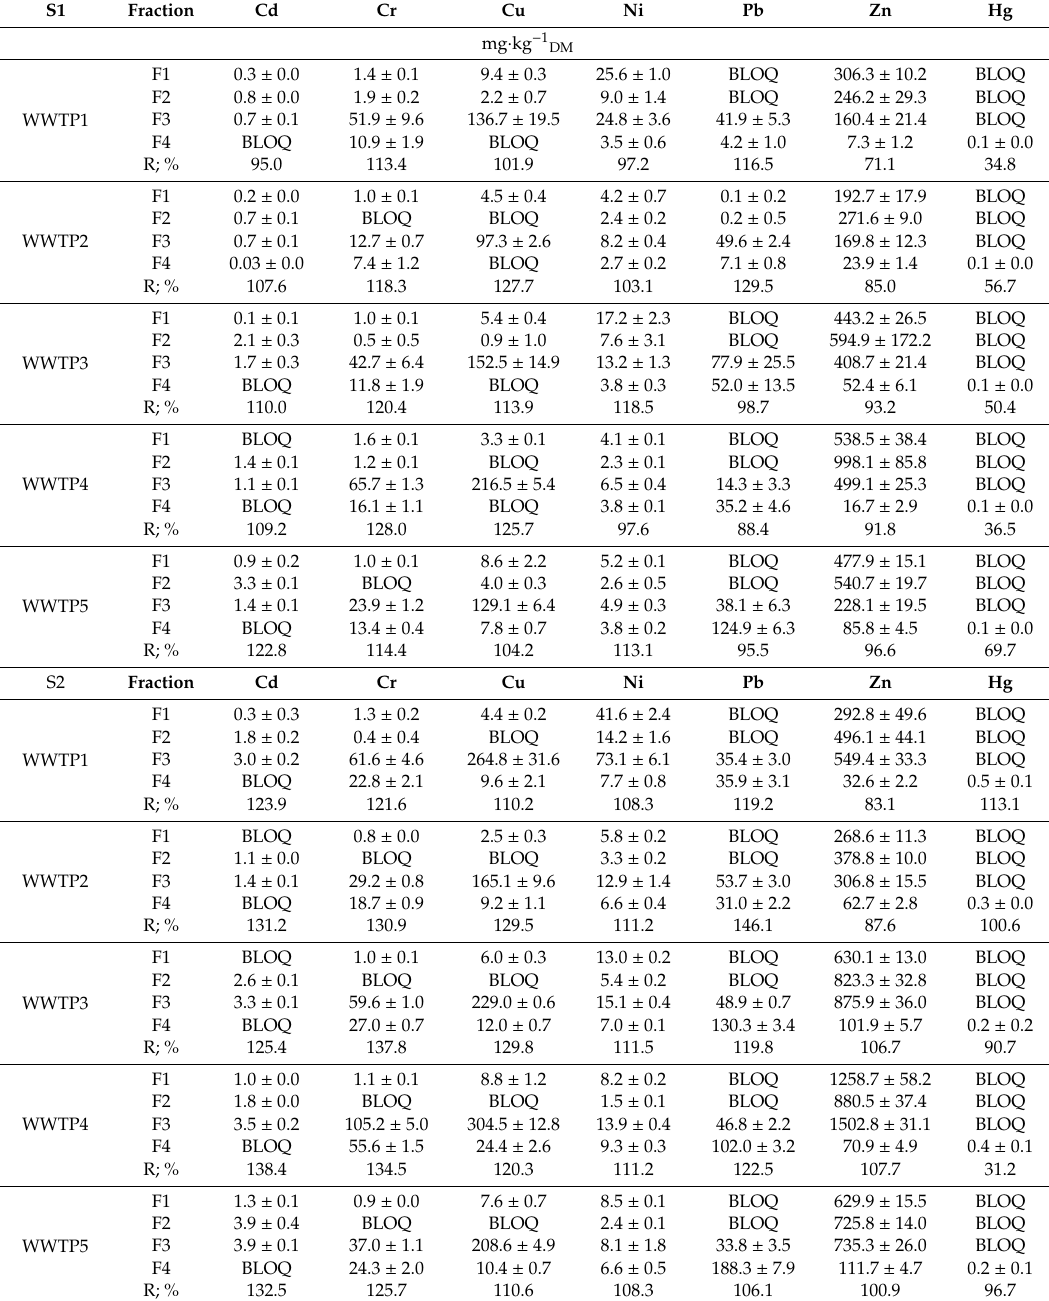
Table 6. Heavy metal concentrations in individual fractions of the sewage sludge